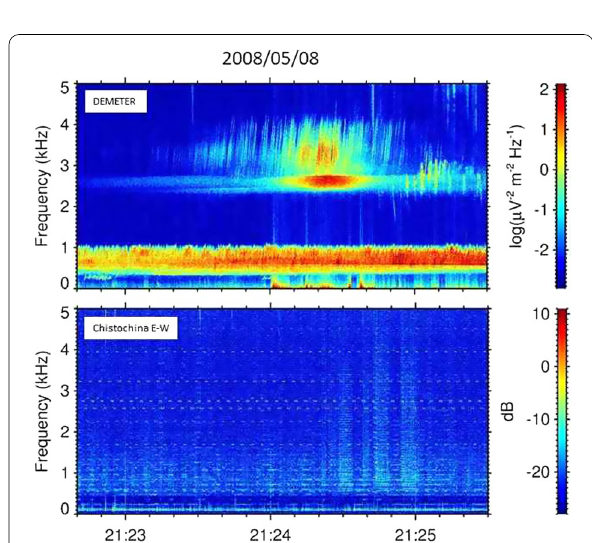
Fig. 12 Spectrograms recorded onboard DEMETER in the Northern hemisphere (top panel), and at Chistochina (bottom panel) between 21:22:40 and 21:25:30 UT in the frequency range 0–5 kHz. The power spectral density is color-coded according to the scale on the